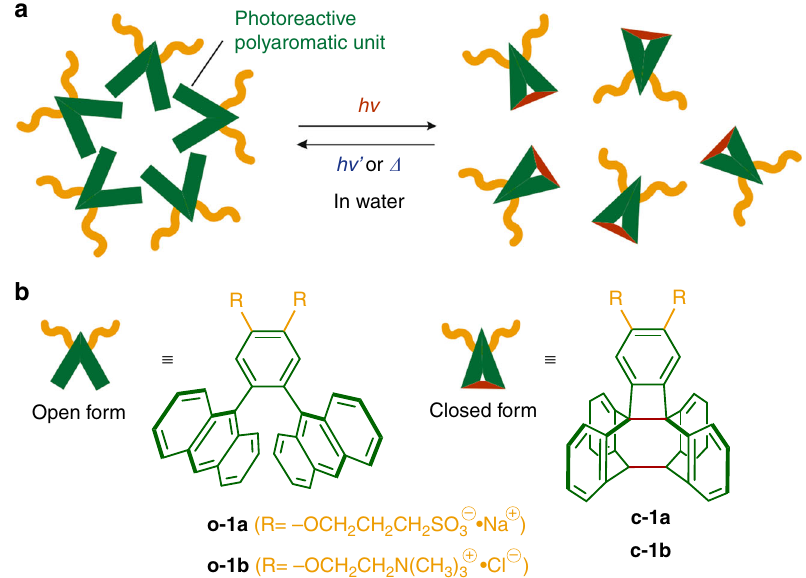
Fig. 1 Concept and molecular design of a photoresponsive nanocapsule. a Schematic representation of a photoresponsive nanocapsule composed of V-shaped amphiphiles bearing a photoreactive ortho- dianthrylbenzene unit. b Chemical structures of V-shaped amphiphiles o-1a , b and their closed forms c-1a , b reported